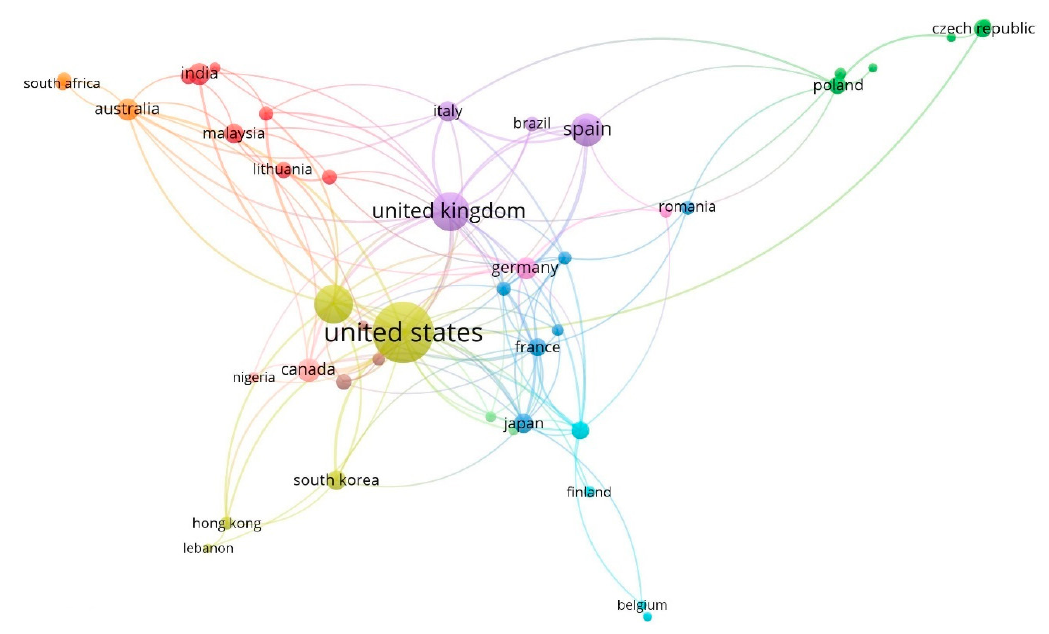
Figure 6. Network of cooperation between countries based on co-authorship (1970–2019).